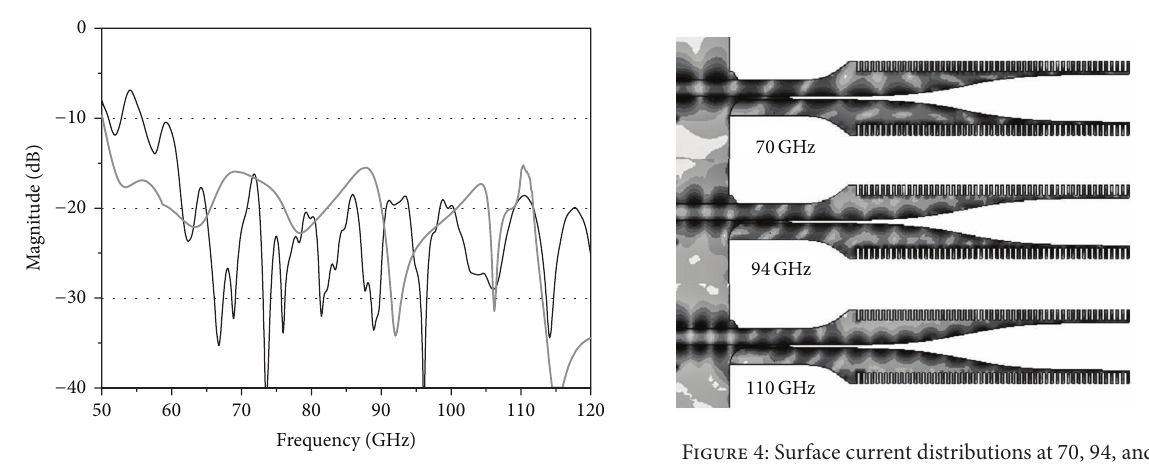
Figure 4: Surface current distributions at 70, 94, and 110GHz.